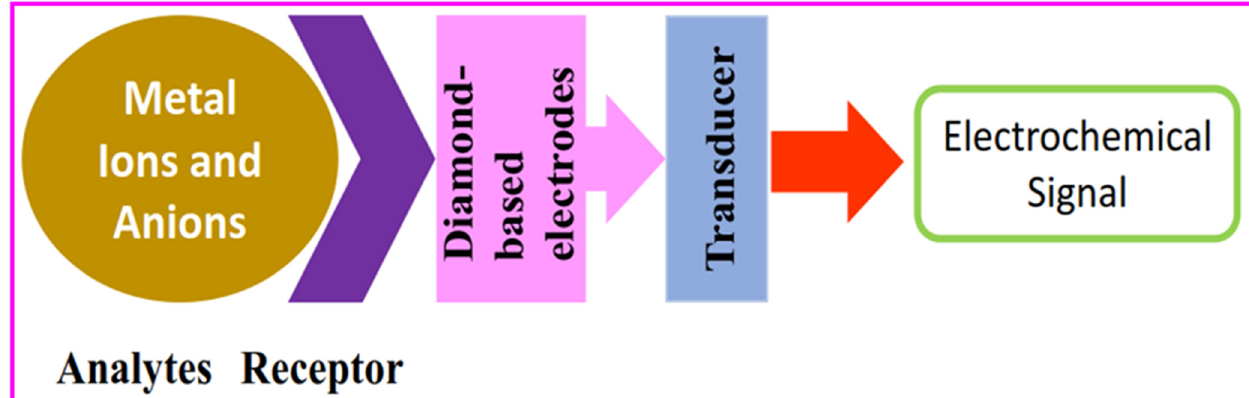
Figure 1. General representation of electrochemical detection of metal ions and anions by diamond- based electrodes.